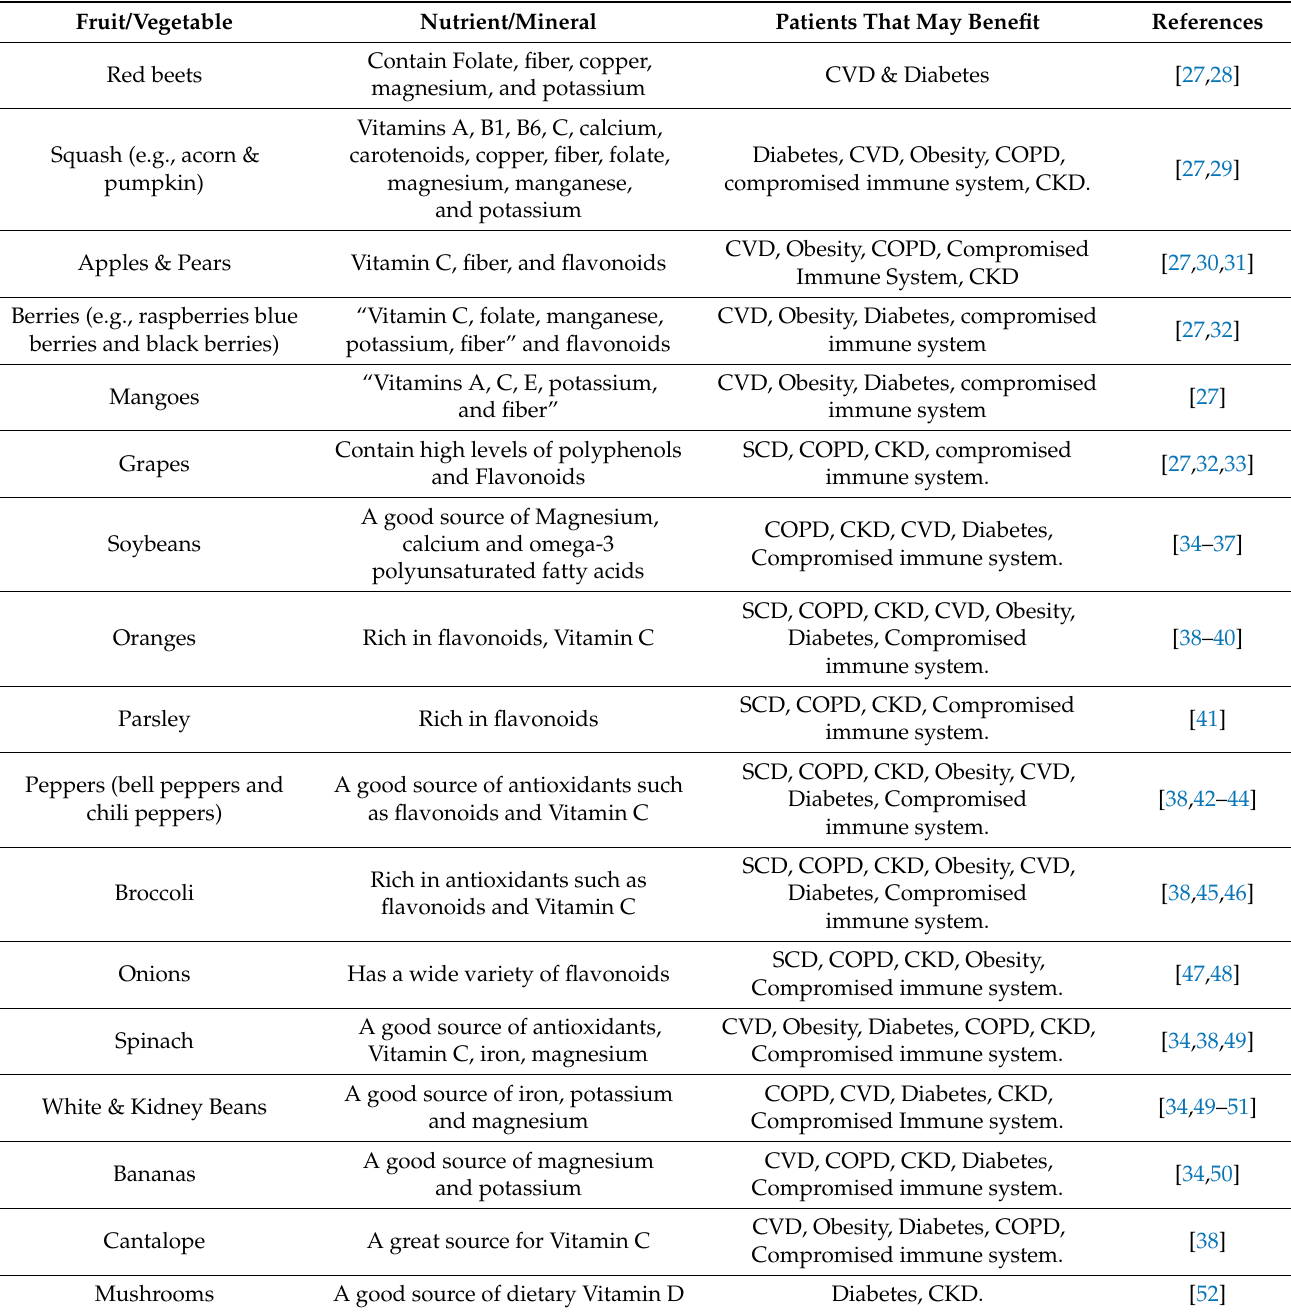
Table 1. Fruits and vegetables, its important nutrients and minerals related to